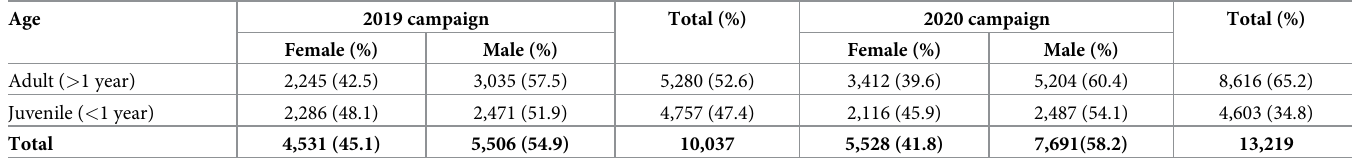
Table 1. Total number of dogs vaccinated aggregated by age and sex during 2019 and 2020 vaccination campaign in the four NCA regions of Namibia. Age